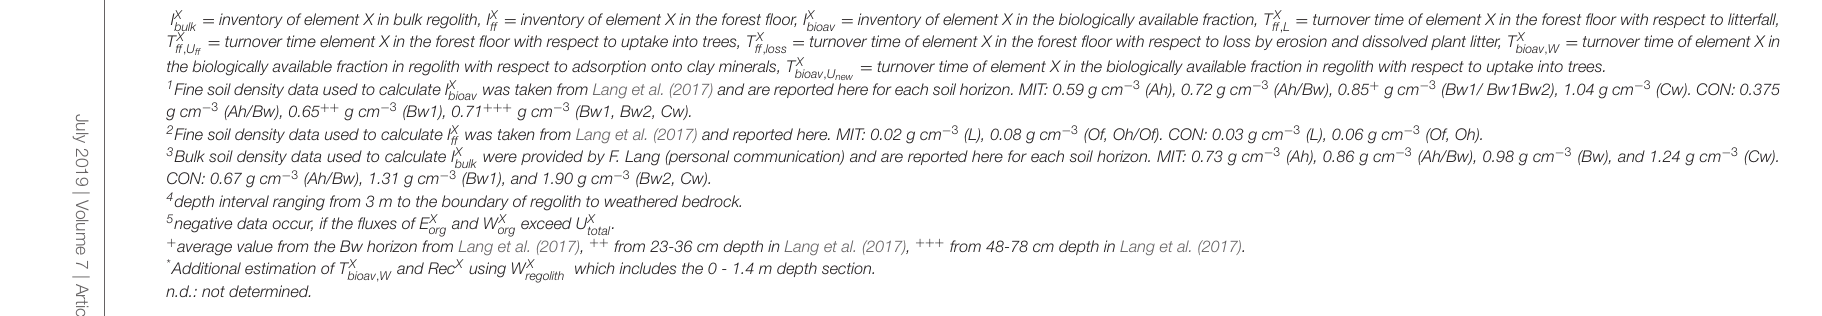
I X bulk = inventory of element X in bulk regolith, I X ff = inventory of element X in the forest floor, I X bioav = inventory of element X in the biologically available fraction, T X ff , L = turnover time of element X in the forest floor with respect to litterfall, = turnover time element X in the forest floor with respect to uptake into trees, T X = turnover time of element X in the forest floor with respect to loss by erosion and dissolved plant litter, T X = turnover time of element X in T X ff , U ff , loss bioav , W ff = turnover time of element X in the biologically available fraction in regolith with respect to uptake into trees. the biologically available fraction in regolith with respect to adsorption onto clay minerals, T X bioav , U new − 3 (Ah), 0.72 g cm − 3 (Ah/Bw), 0.85 + g cm − 3 (Bw1/ Bw1Bw2), 1.04 g cm − 3 (Cw). CON: 0.375 1 Fine soil density data used to calculate I X bioav was taken from Lang et al. (2017) and are reported here for each soil horizon. MIT: 0.59 g cm g cm − 3 (Ah/Bw), 0.65 ++ g cm − 3 (Bw1), 0.71 +++ g cm − 3 (Bw1, Bw2, Cw). − 3 (L), 0.08 g cm − 3 (Of, Oh/Of). CON: 0.03 g cm − 3 (L), 0.06 g cm − 3 (Of, Oh). 2 Fine soil density data used to calculate I X ff was taken from Lang et al. (2017) and reported here. MIT: 0.02 g cm − 3 (Ah), 0.86 g cm − 3 (Ah/Bw), 0.98 g cm − 3 (Bw), and 1.24 g cm − 3 (Cw). 3 Bulk soil density data used to calculate I X bulk were provided by F. Lang (personal communication) and are reported here for each soil horizon. MIT: 0.73 g cm CON: 0.67 g cm − 3 (Ah/Bw), 1.31 g cm − 3 (Bw1), and 1.90 g cm − 3 (Bw2, Cw). 4 depth interval ranging from 3 m to the boundary of regolith to weathered bedrock. X 5 negative data occur, if the fluxes of E X X org and W org exceed U total . + average value from the Bw horizon from Lang et al. (2017), ++ from 23-36 cm depth in Lang et al. (2017), +++ from 48-78 cm depth in Lang et al. (2017). X using W X * Additional estimation of T X bioav , W and Rec regolith which includes the 0 - 1.4 m depth section. n.d.: not